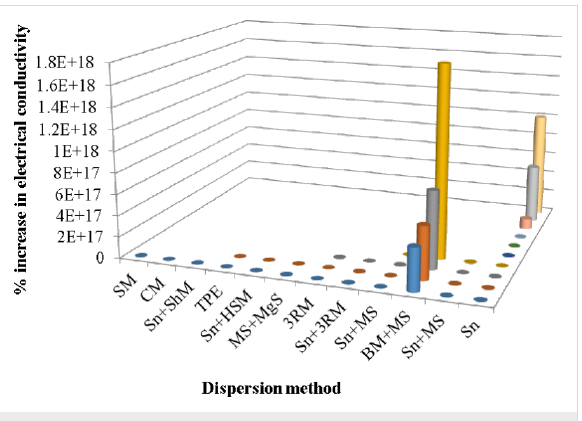
Figure 19: Increase in electrical conductivity as a function of disper- sion method